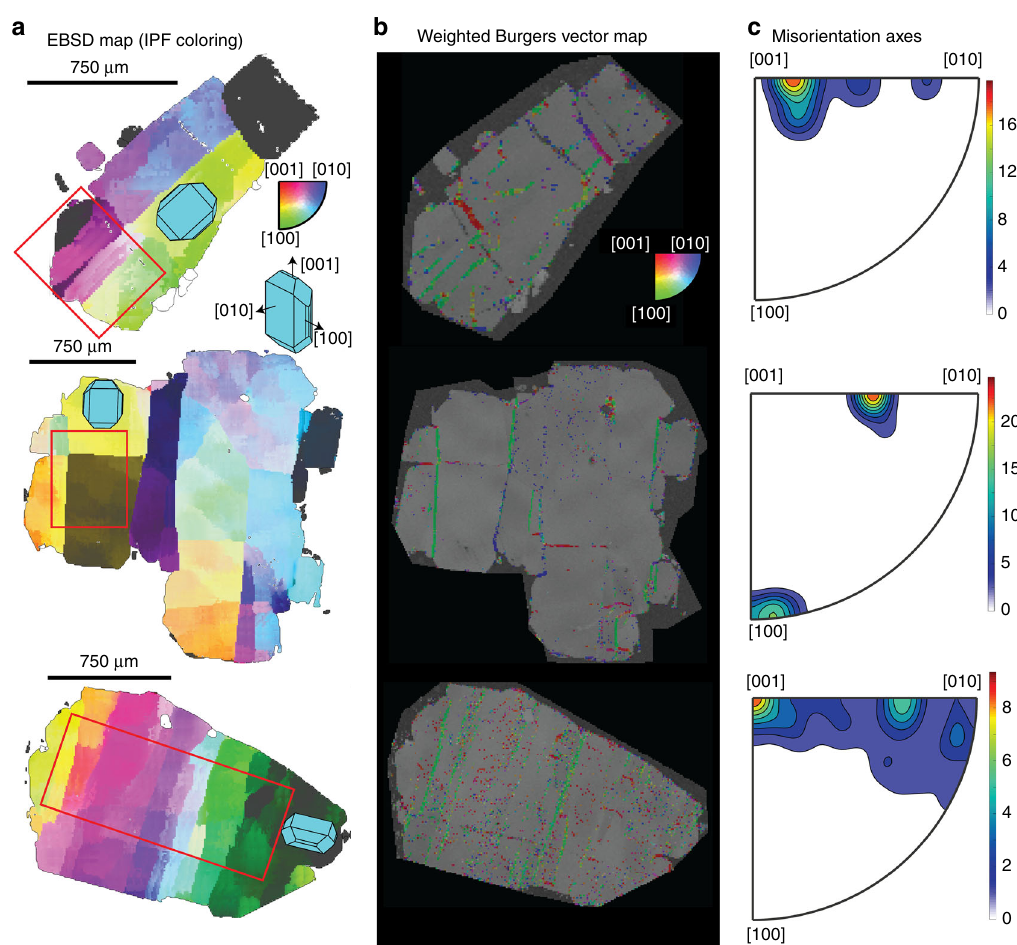
Fig. 4 Crystallographic signatures of lattice distortions within K ī lauean olivines. a Electron backscatter diffraction (EBSD) maps colored using the inverse pole fi gure (IPF) key as in Fig. 2 (scaled to 3°). 3D olivine shapes are overlain to demonstrate the average orientation of the olivine crystal with respect to the three crystallographic axes. b Weighted Burgers vector directions (WBVDs) overlain on band contrast maps ([100] = green, [010] = blue, [001] = red]). Scale for both images shown on EBSD map. c Misorientation axes across subgrain boundaries located within the red box indicated in column a . The color scale has units of “ multiples of uniform distribution ” . Subgrain boundaries with [100] WBVDs (green) show misorientation axes between [001] and [010]. Subgrain boundaries with [001] WBVDs (red) show misorientation axes about [100] or